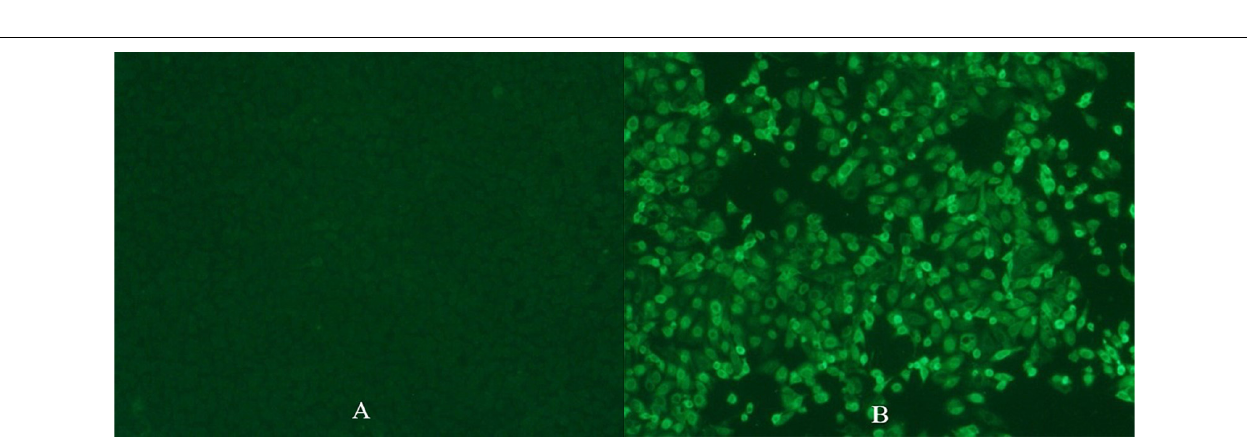
FIGURE 6 | Immunofluorescence staining of cells inoculated with control impinger fluid (A) or PRRSV impinger fluid (B) with PRRSV-specific antibody conjugated to FITC. Pictures were taken on 6 days postinoculation when the MARC-145 cell plates were fixed using 80% acetone and stained by SDOW-17 PRRSV FITC conjugate. Magnification, ×